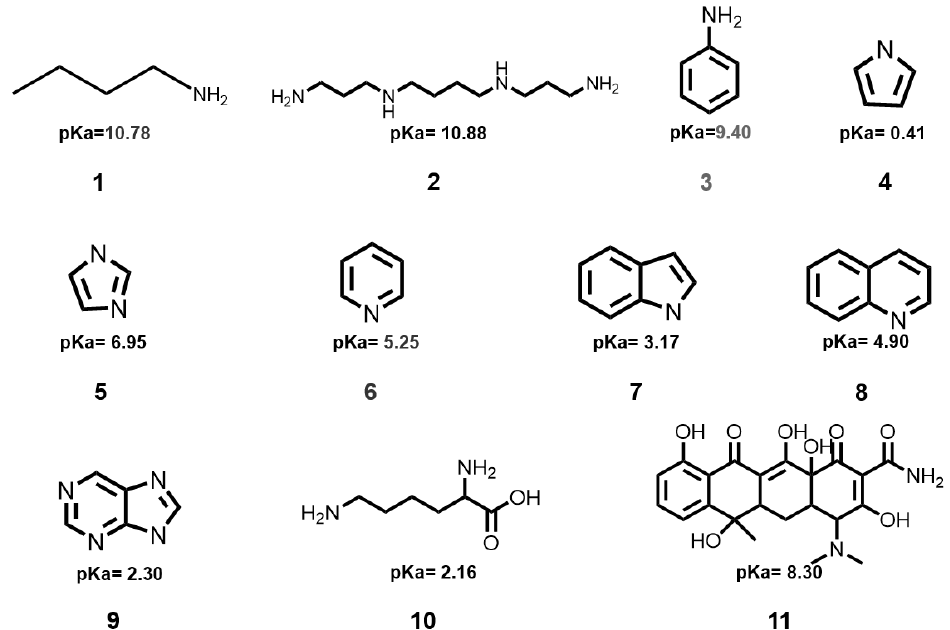
Figure 1. Chemical structures of NCOBs discussed in this article as well as the pKa of their conjugated acids (CA), the pKa values were obtained from reference [13].